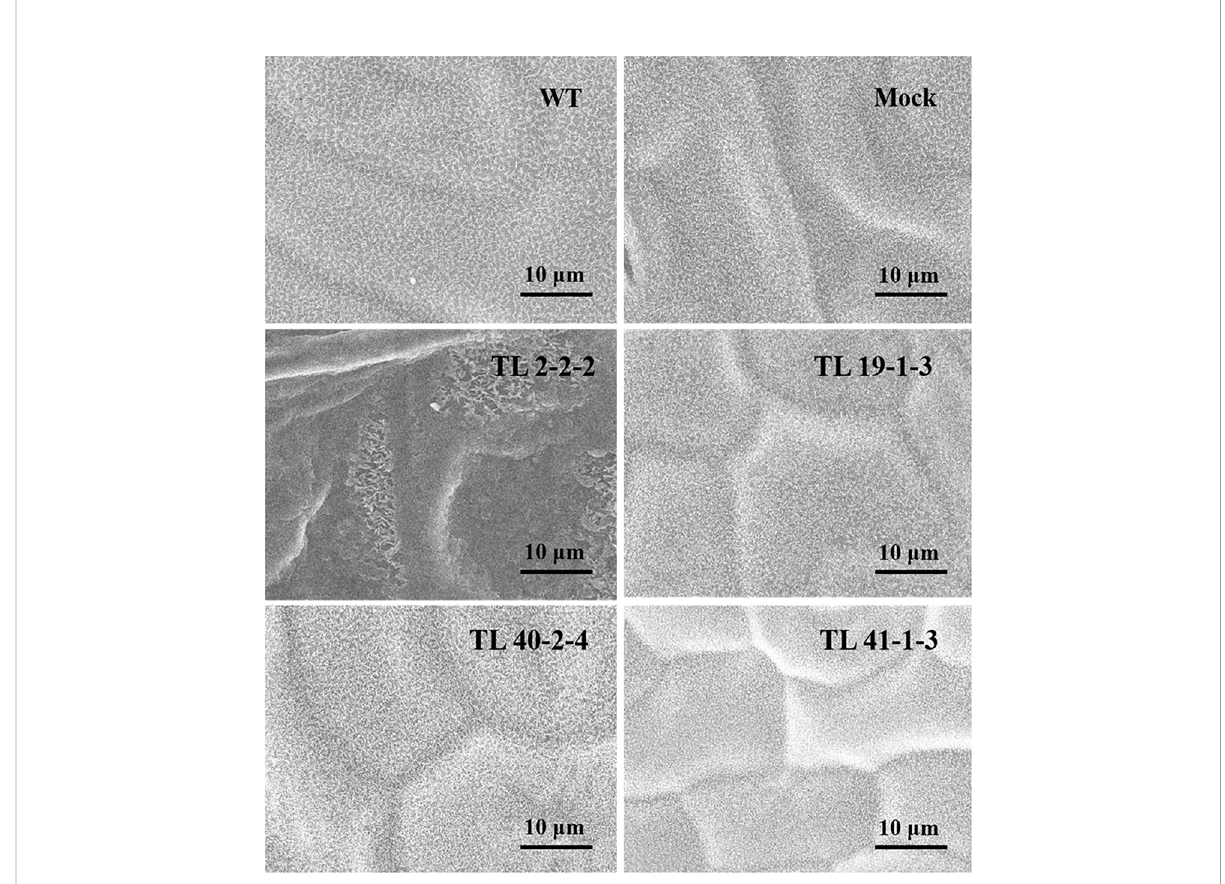
FIGURE 5 Scanning electron microscope (SEM) analysis of wax deposition on leaf surface in groundnut transgenics under drought stress: The image depicting the variation in deposition of cuticular waxes on the leaf surface (adaxial surface) of wild type (WT), mock and multigene transgenic groundnut lines (TL 2-2-2, TL 19-1-3, TL 40-2-4 and TL 41-1-3) under drought stress. The SEM images were taken at 10 m m focal